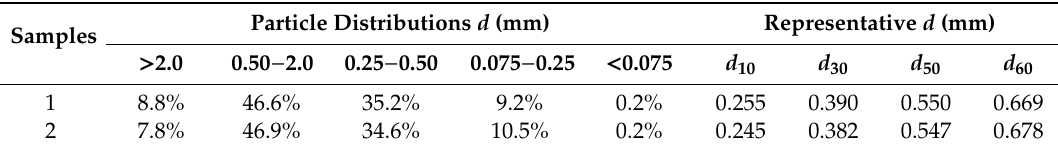
Table 2. Bed materials components and particle distributions.